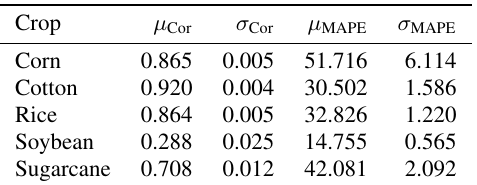
Figure 2. Scatter plots showing the performance of the best trained models. The vertical axis shows the predicted values, while the horizontal axis shows the actual values. All evaluation points are related to crop production in Brazil in 2018. Predictions were only performed for municipalities that actually produced the crop in the evaluation year. Points were colored differently to show densities of regions in the plots.